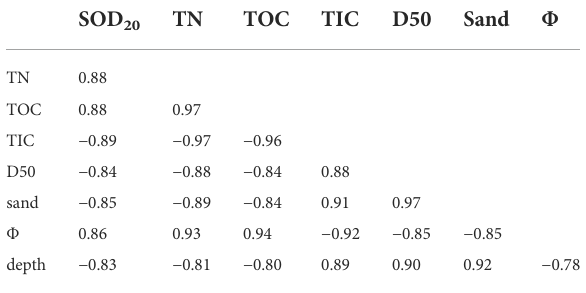
TABLE 3 Pearson correlation matrix calculated among variables measured in the sediment collected in May 2021 at 16 sites, mean SOD 20 rate in the 2021 and site depth. Two SOD 20 rates measured in SS3andSS4inOctoberwereexcluded.Allcorrelationcoef fi